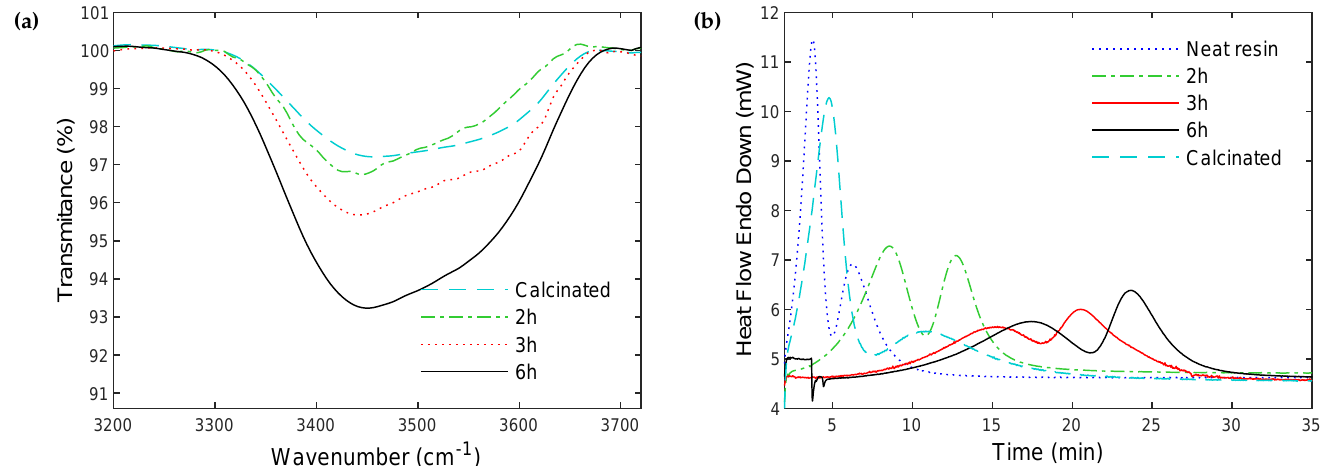
Figure 6. ( a ) FTIR spectra of glass particles calcinated for 10 h and subsequently partially rehydrox- ylated in the silanization solution (without the silane) for different durations. ( b ) Polymerization and crystallization heat flow curves during isothermal synthesis at 180 ◦ C of PA6-glass particles composites, synthesized with partially rehydroxylated particles for 2 h, 3 h and 6 h in the silanization solution (without the silane agent), compared to the DSC curves of the pure resin and PA6-glass particles composites synthesized with the calcinated particles.